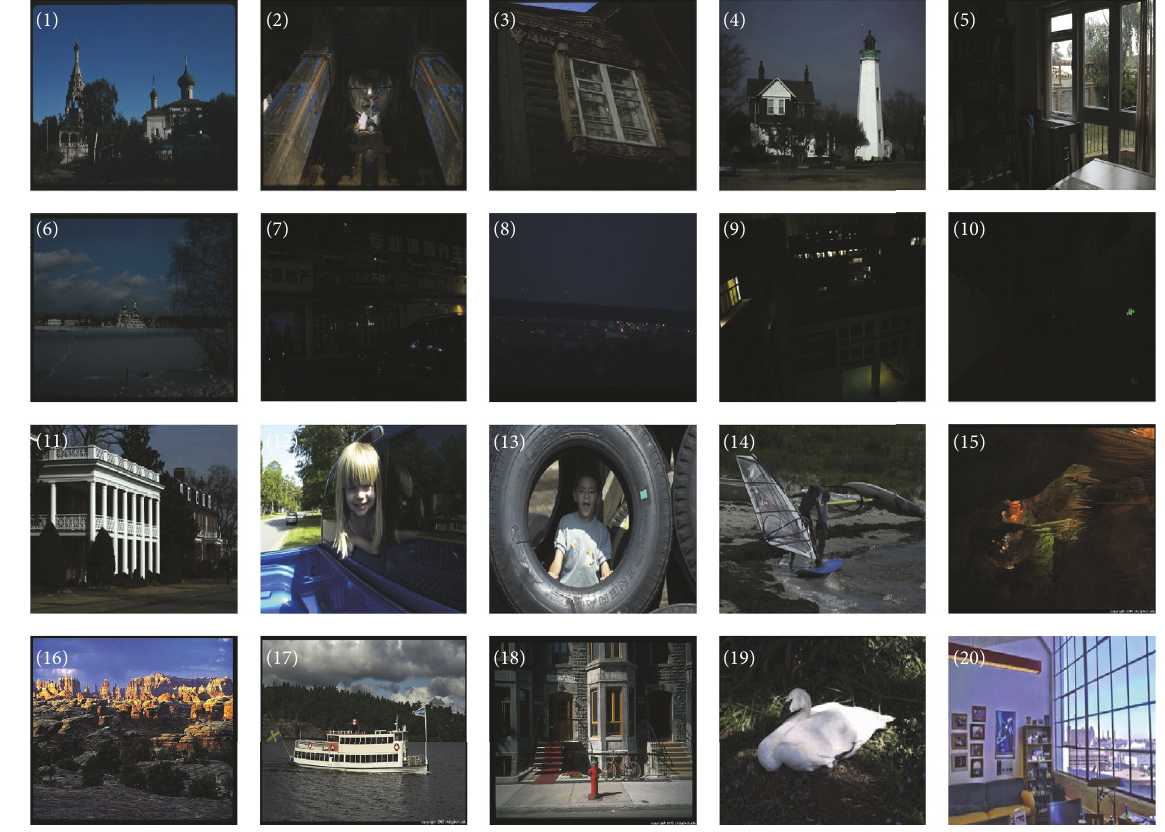
Figure 10: Datasets used in experiments.